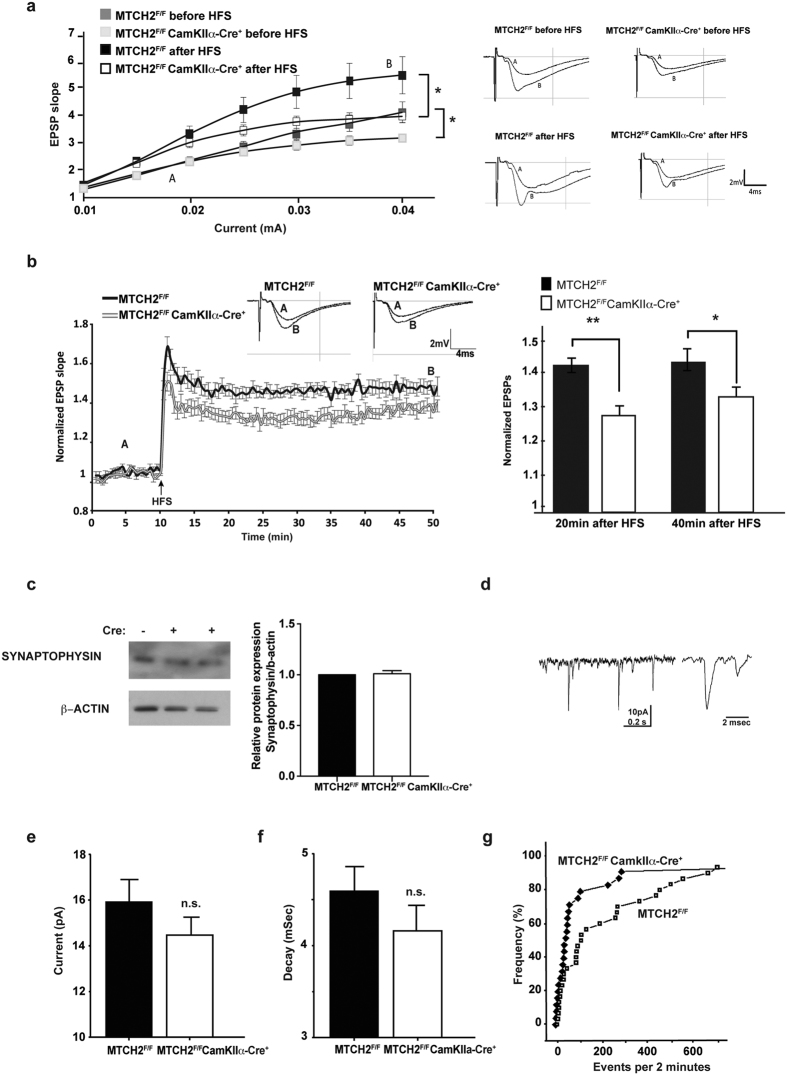
Hippocampal LTP is impaired in slices of MTCH2F/FCamKIIα-Cre+ mice.(a) Ratio of field excitatory postsynaptic potential (EPSP) slope (abscissa) to stimulus intensity (ordinate). At high-intensity (0.04 mA), input-output was significantly reduced in slices from MTCH2F/FCamKIIα-Cre+ mice compared to MTCH2F/F, both before and 40 min after LTP induction. (b) Normalized EPSP slopes recorded before (A) and after high-frequency stimulation (HFS, 100 Hz, 1 s, applied at arrowhead at twice of the test intensity). Representative recordings are shown above the records. Right panel: mean response change recorded in the slices at 20 and 40 minutes after the tetanic stimulation (**p < 0.01, *p < 0.05; n = 9–14 slices, from 3 mice/each genotype). (c) Western blot analysis of synaptophysin in primary hippocampal neurons prepared from MTCH2F/F(−) and MTCH2F/F
CamKIIα-Cre+ (+) mice. β-Actin served as a loading control. (d) Sample illustration of the recording (left) and an expanded image of a single mEPSC (right). (e) Mean sizes (in pA) of mEPSCs of MTCH2F/F(n = 29 cells) and MTCH2F/F
CamKIIα-Cre+ (n = 24 cells) from 5 independent experiments. (f) Decay time (in msec) of the two groups described in (e). (g) Cumulative histogram, where each cell is represented once, with the number of events per 2 minute recording time on the abscissa, and cumulative number of cells on the ordinate. There were many more MTCH2F/Fcells with a larger number of events during the recording interval (p < 0.001, non-parametric test).